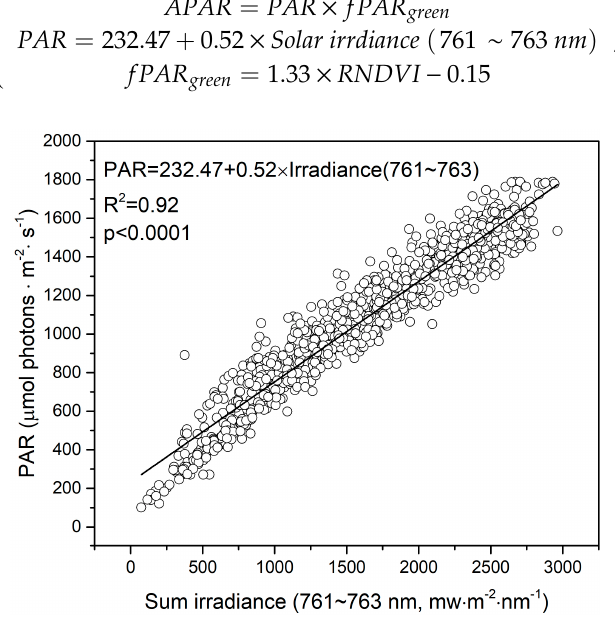
Figure 1. The relationship between the received photosynthetically active radiation (PAR) and the accumulated irradiance from 761 to 763 nm. All the measurements were collected for wheat from 20 April to 19 May 2017.